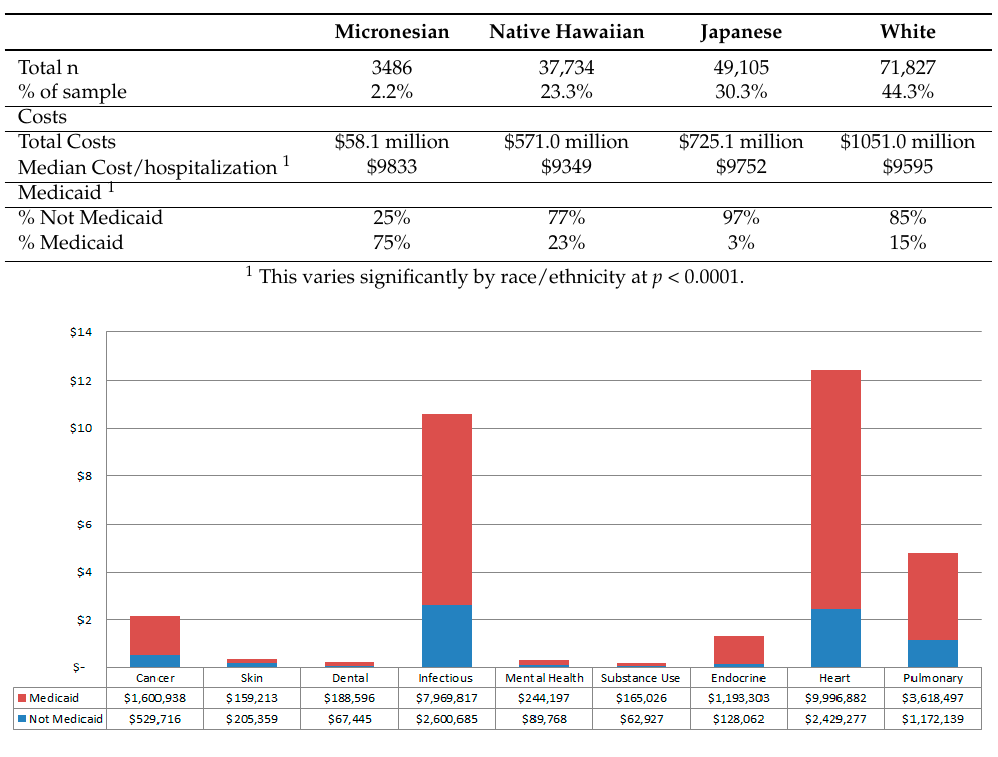
Table 1. Totals Costs in US Dollars and in Percent Medicaid vs. Not Medicaid by Racial/Ethnic Group from all non-pregnancy related hospital discharges for Micronesians, Native Hawaiians, Japanese, and whites in Hawai‘i from 2010–2012 (n = 162,152 hospitalizations).